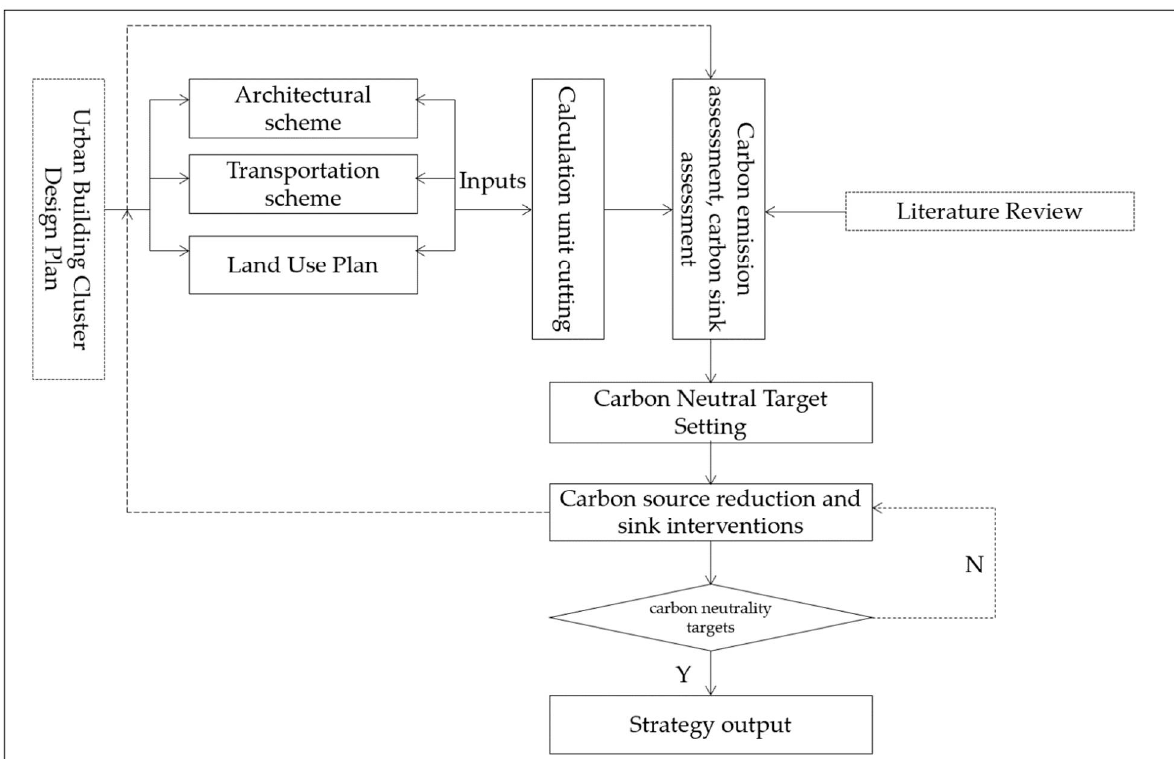
Figure 5. Carbon evaluation and intervention model design.